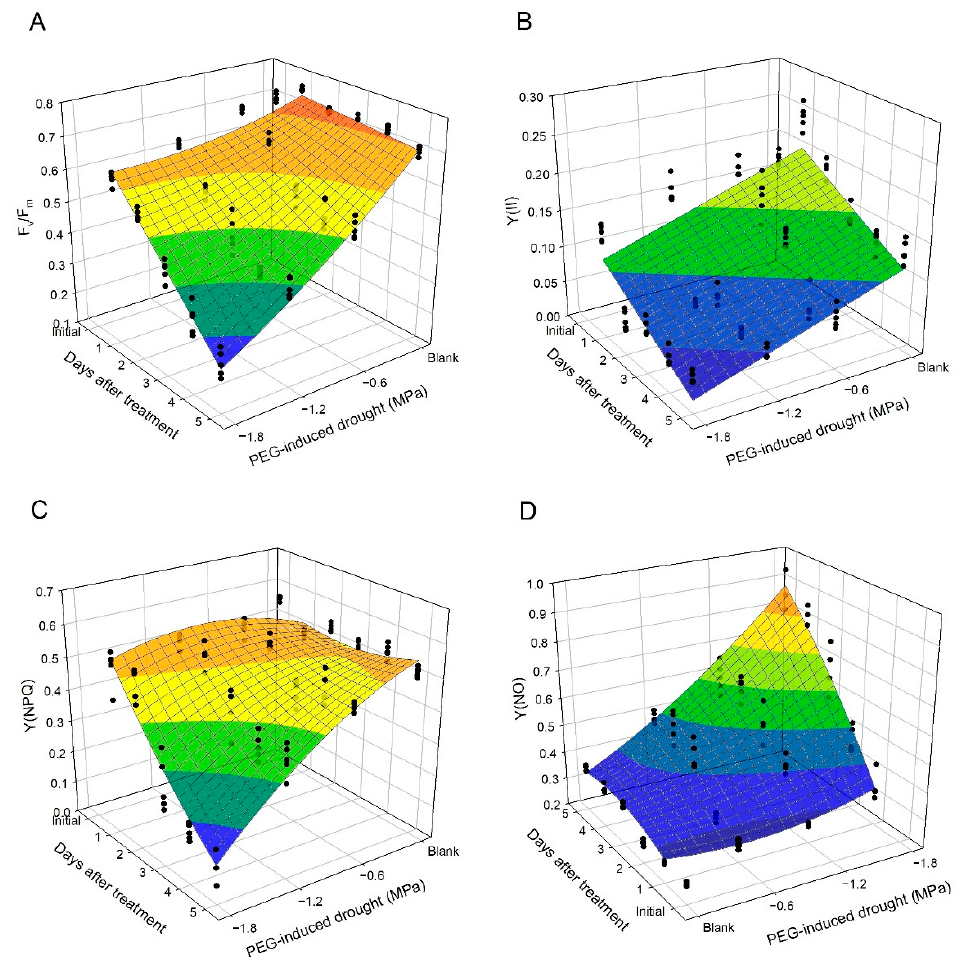
Figure 2. Scatter plots and regression surfaces of the maximum quantum yield of PSII (F v /F m ) ( A ) , actual photosynthetic efficiency of PS II (Y(II)) ( B ), quantum yield of regulated energy dissipation (Y(NPQ)) ( C ), and quantum yield of non-regulated energy dissipation (Y(NO)) ( D ) value in tea leaf discs as affected by PEG-induced osmotic stress during a 5-day period.